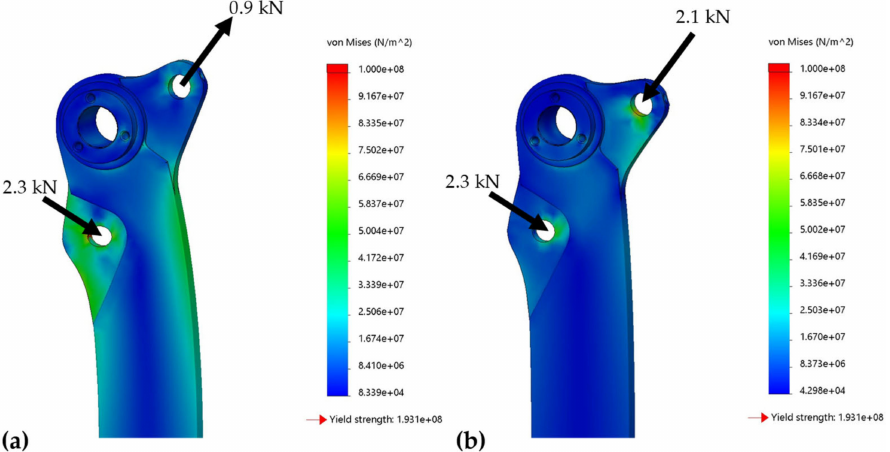
Figure 20. Stress analysis of the shank part: ( a ) high torque transfer case; ( b ) high internal force case.